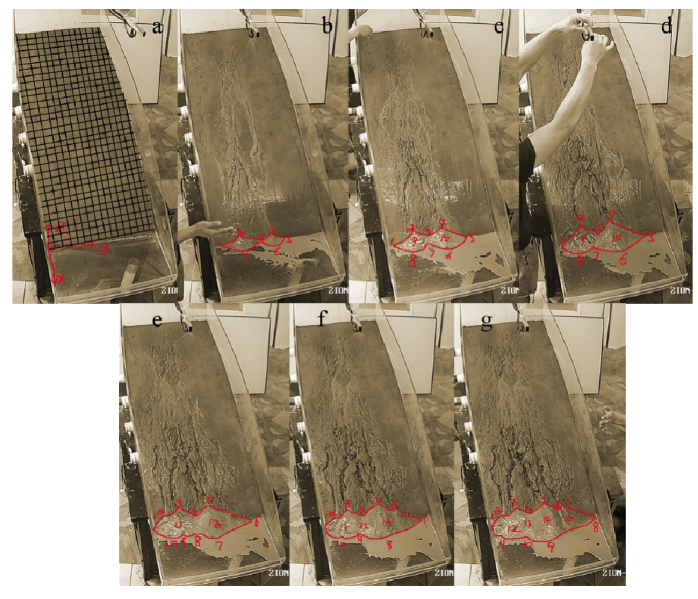
Figure 3. Sediment volume under 25 mm/h at ( a ) 0 min, ( b ) 1 min, ( c ) 2 min, ( d ) 3 min, ( e ) 4 min, ( f ) 5 min, ( g ) 6 min.